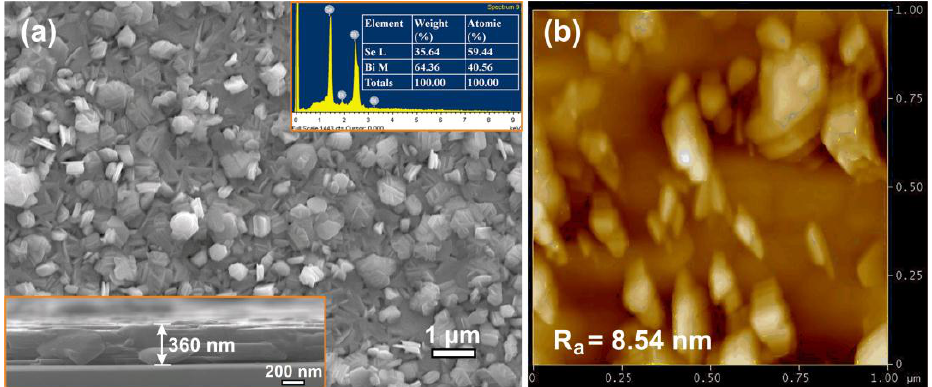
Figure 2. ( a ) A plane-view SEM image of the Bi 2 Se 3 thin film deposited on c -plane sapphire. Lower inset: a cross-sectional SEM image of the film; upper inset: The energy-dispersive X-ray spectroscopy (EDS) spectra and relative compositions of the film. ( b ) AFM image of the film, R a is the center line average roughness.